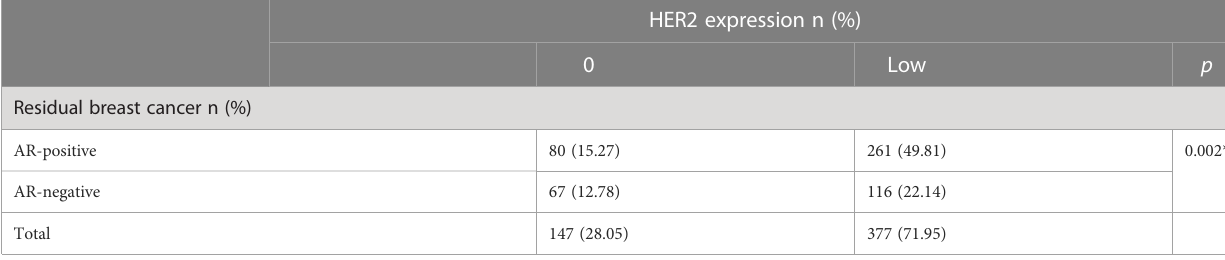
TABLE 5 Distribution of breast cancer patients with HER2-negative in different AR